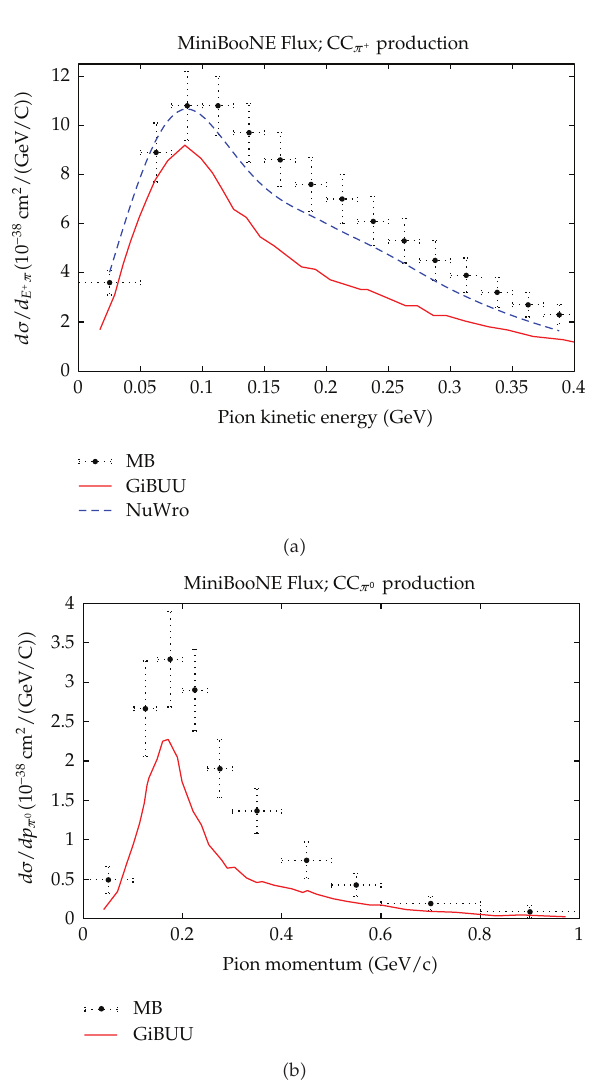
Figure 5: (cid:4) a (cid:5) Di ff erential cross section for CC1 π (cid:9) production in the final state (cid:4) all the FSI e ff ects are included (cid:5) . MiniBooNE measurement (cid:6) 77 (cid:7) is compared to GiBUU (cid:6) 78 (cid:7) and NuWro computations. (cid:4) b (cid:5) The same for CC π 0 production, but only GIBUU results are